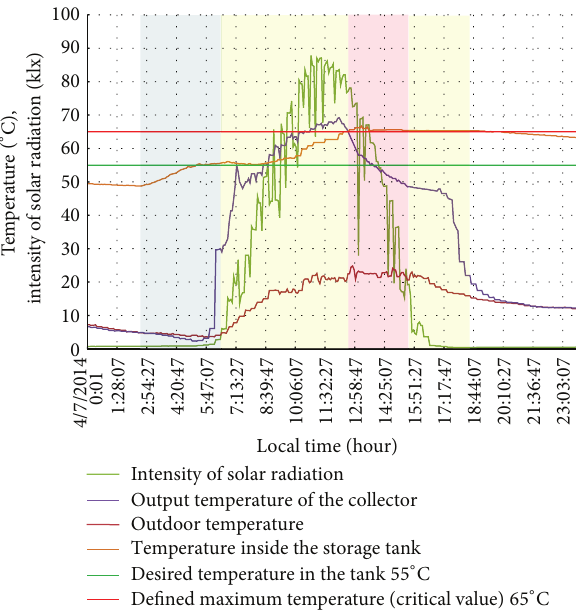
Figure 23: The courses of the monitored values in the experiment on the stagnation correction.